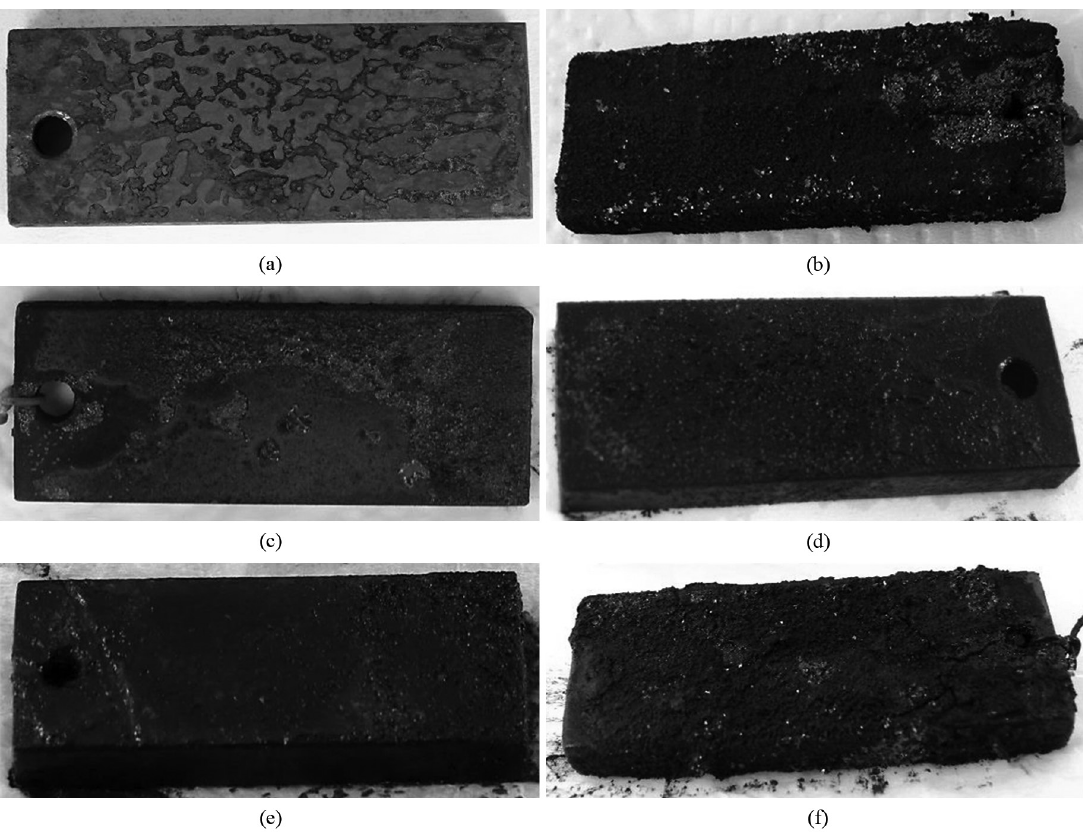
Figure 5. a) Welded joint in brine, pH=5.0; b) base metal in brine, pH = 3.0; c) welded joint in solution 1, pH= 5.0; d) welded joint in solution 1, pH=3.0; e) welded joint in solution 2, pH=5.0; f) welded joint in solution 2,